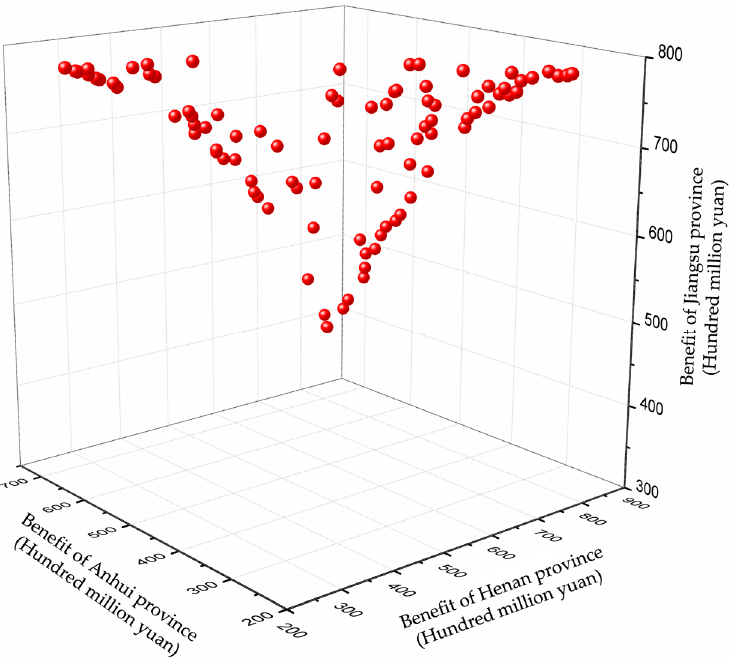
Figure 4. Pareto front of multi-objective optimization based on the NSGA-II method in the Huaihe River basin.